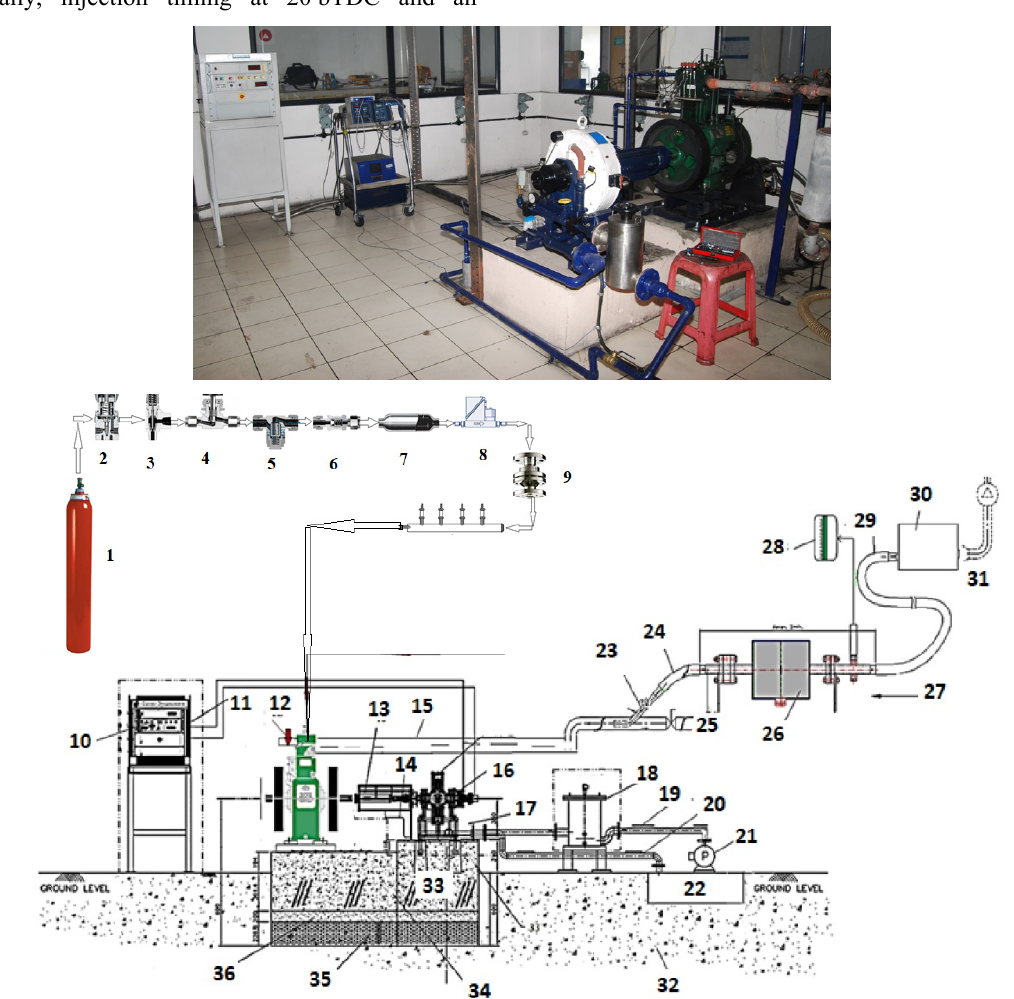
Figure 1 Engine Test Setup 1- GH 2 Cylinder, 2- Two-stage Pressure Regulator, 3-Relief Valve, 4-Two Way Valve, 5-Filter, 6-Non- Return Valve, 7-GH 2 Reservoir, 8-Mass Flow Controller, 9-Flame Arrester, 10-Dynamometer Controller Unit, 11-Diesel Engine, 12-GH 2 LLRF Introducing system, 13-Propeller Shaft Guard, 14-Exhaust Manifold, 15- Eddy Current Dynamometer,16-Magnetic Pickup, 17-Magenetic Filter, 18-Sampling Probe, 19-Flexible Hose, 20-Exhaust Out,21-Exhaust Damper, 22-Sampling System, 23-Flexible Hose, 24-Manometer, 25-Smoke Meter Sensor Unit, 26-Sump Tank, 27-Dynamometer Foundation, 28-Rubble Soiling (9”), 30-Thin Concrete Layer (4”), 31-Propeller Shaft Mounting, 32-Pump, 33-Inlet Pipe, 34-Outlet Pipe, 35-Soil, 36- Load Cell of